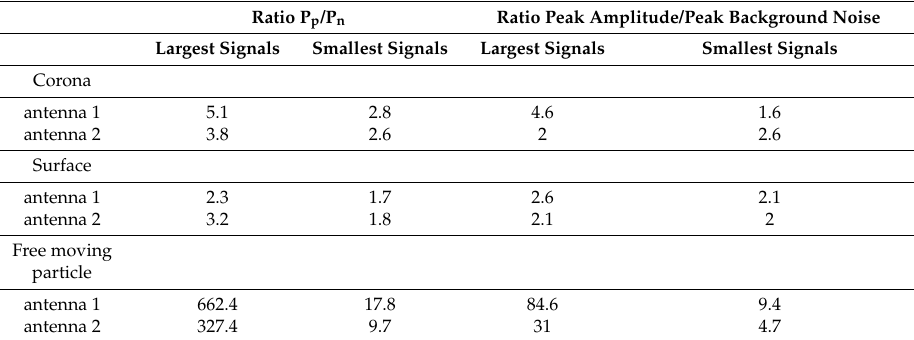
Table 4. Power and amplitudes ratios.